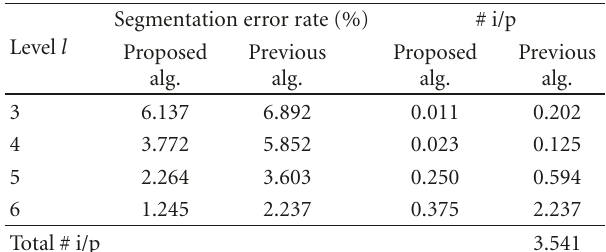
Table 5: Comparisons of performance in terms of segmentation error rates and computational cost measured by number of iteration per pixels (# i/p) for Image III of Figure